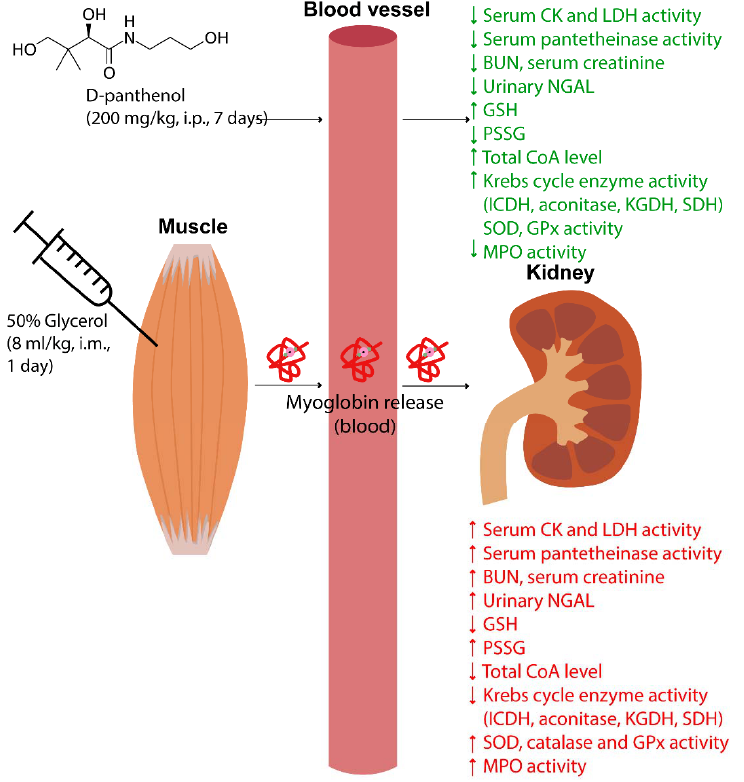
Figure 8. Metabolic effects of dexpanthenol in glycerol-induced rhabdomyolysis and acute renal failure in rats.